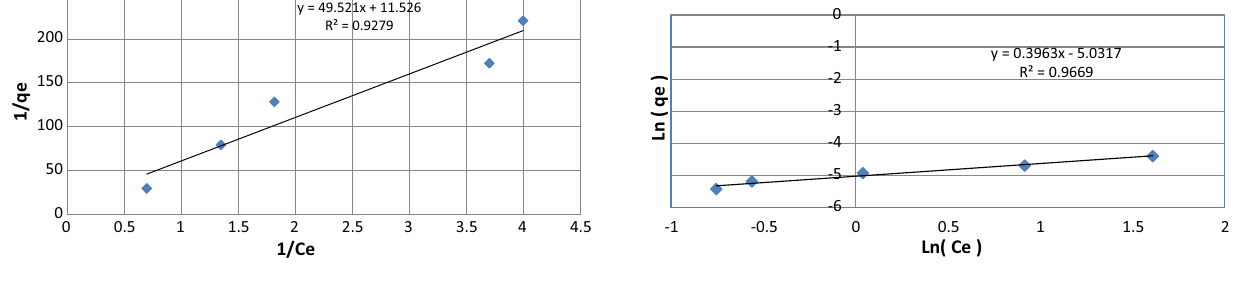
Fig. 7 Relationship between 1/ q limestone size (3.75 mm) and C 0 (7.04 mg/l) Table 7 Calculated values for the different initial concentrations and Limestone sizes to plot Langmuir adsorption isotherm